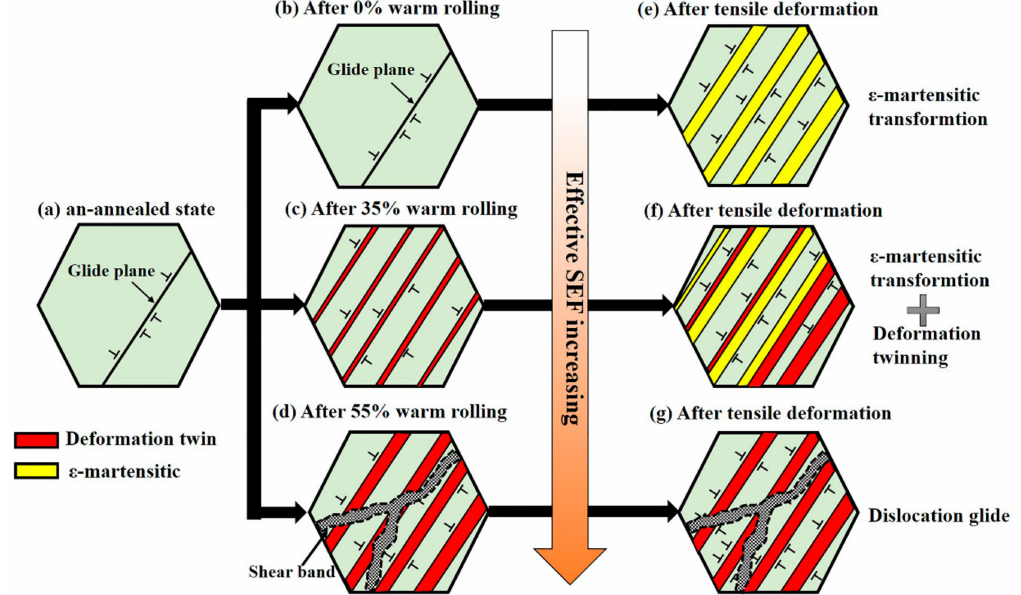
Figure 10. A schematic sketch of microstructure evolution during warm rolling and tensile deformation (green, red and yellow colors denote austenite matrix, deformation twin and ε -martensite,